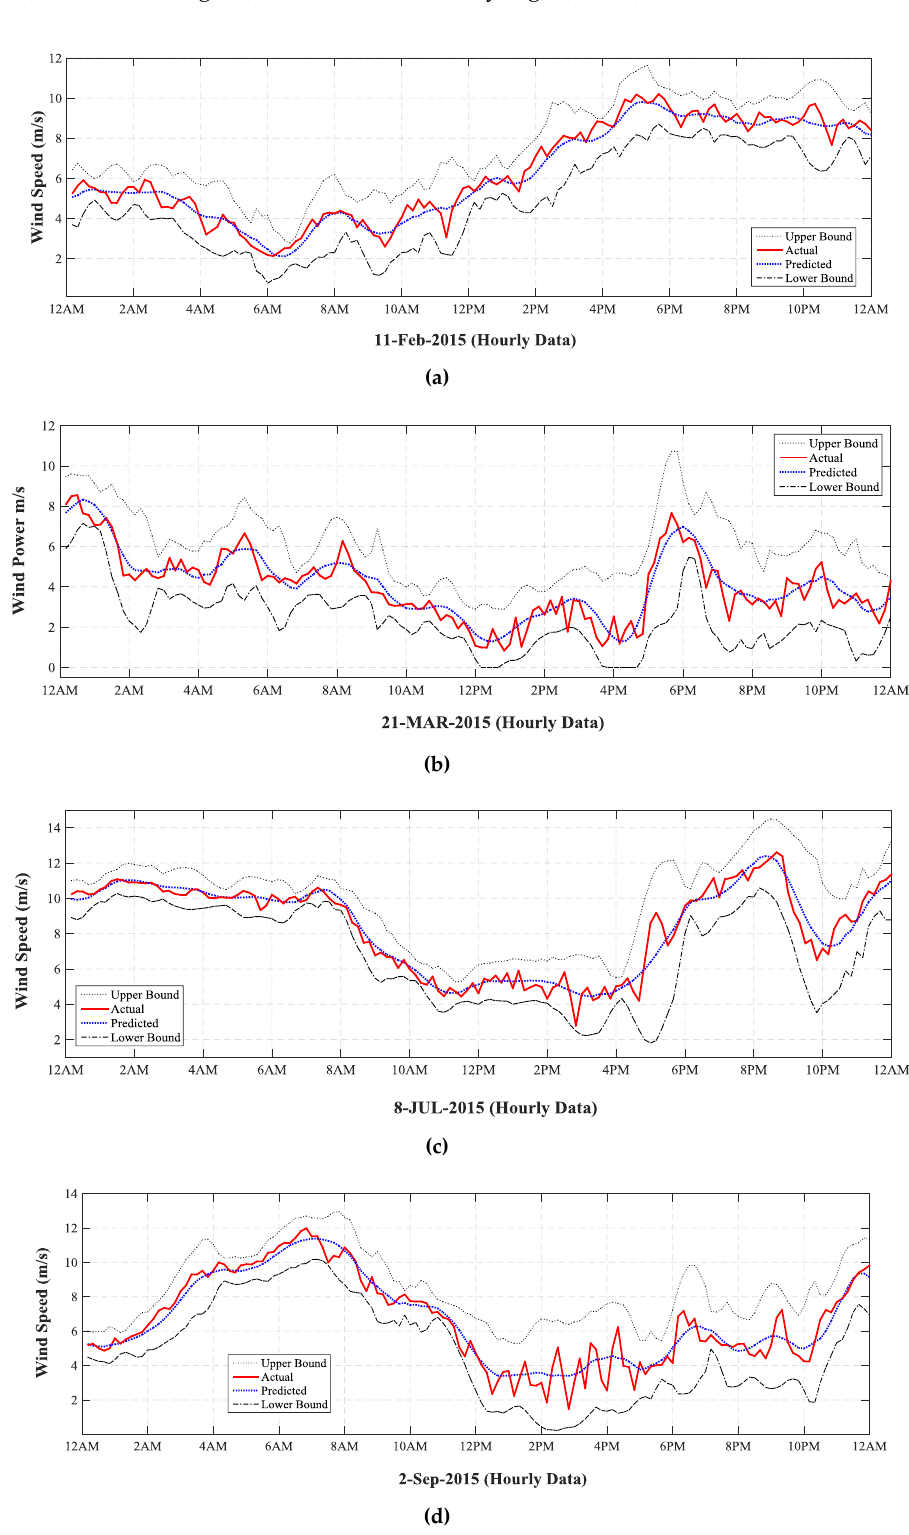
Figure 12. 1-hour-ahead probabilistic nowcasting using 7-perturbed ensemble NARX model: ( a ) Winter, ( b ) spring, ( c ) summer, and ( d )